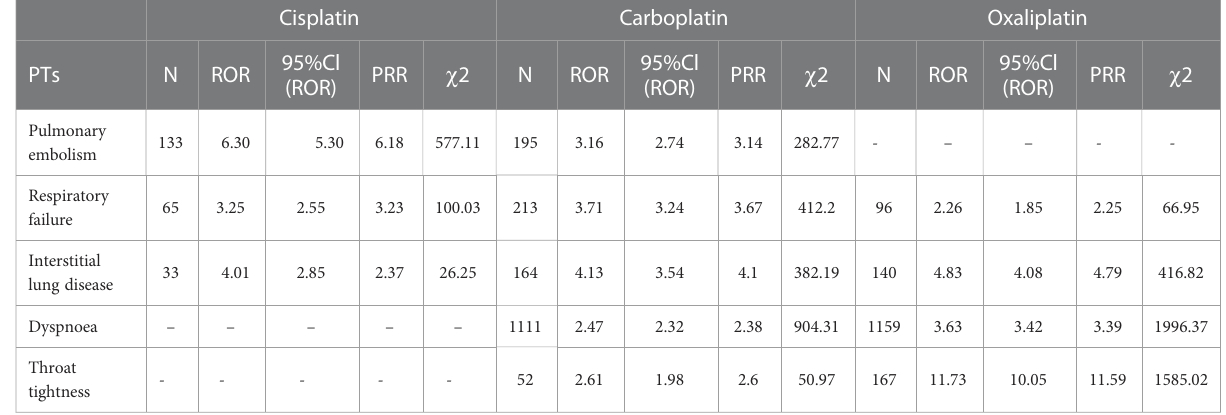
TABLE 7 Respiratory, thoracic and mediastinal disorder-related adverse events of Cisplatin, Carboplatin and Oxaliplatin. Cisplatin Carboplatin